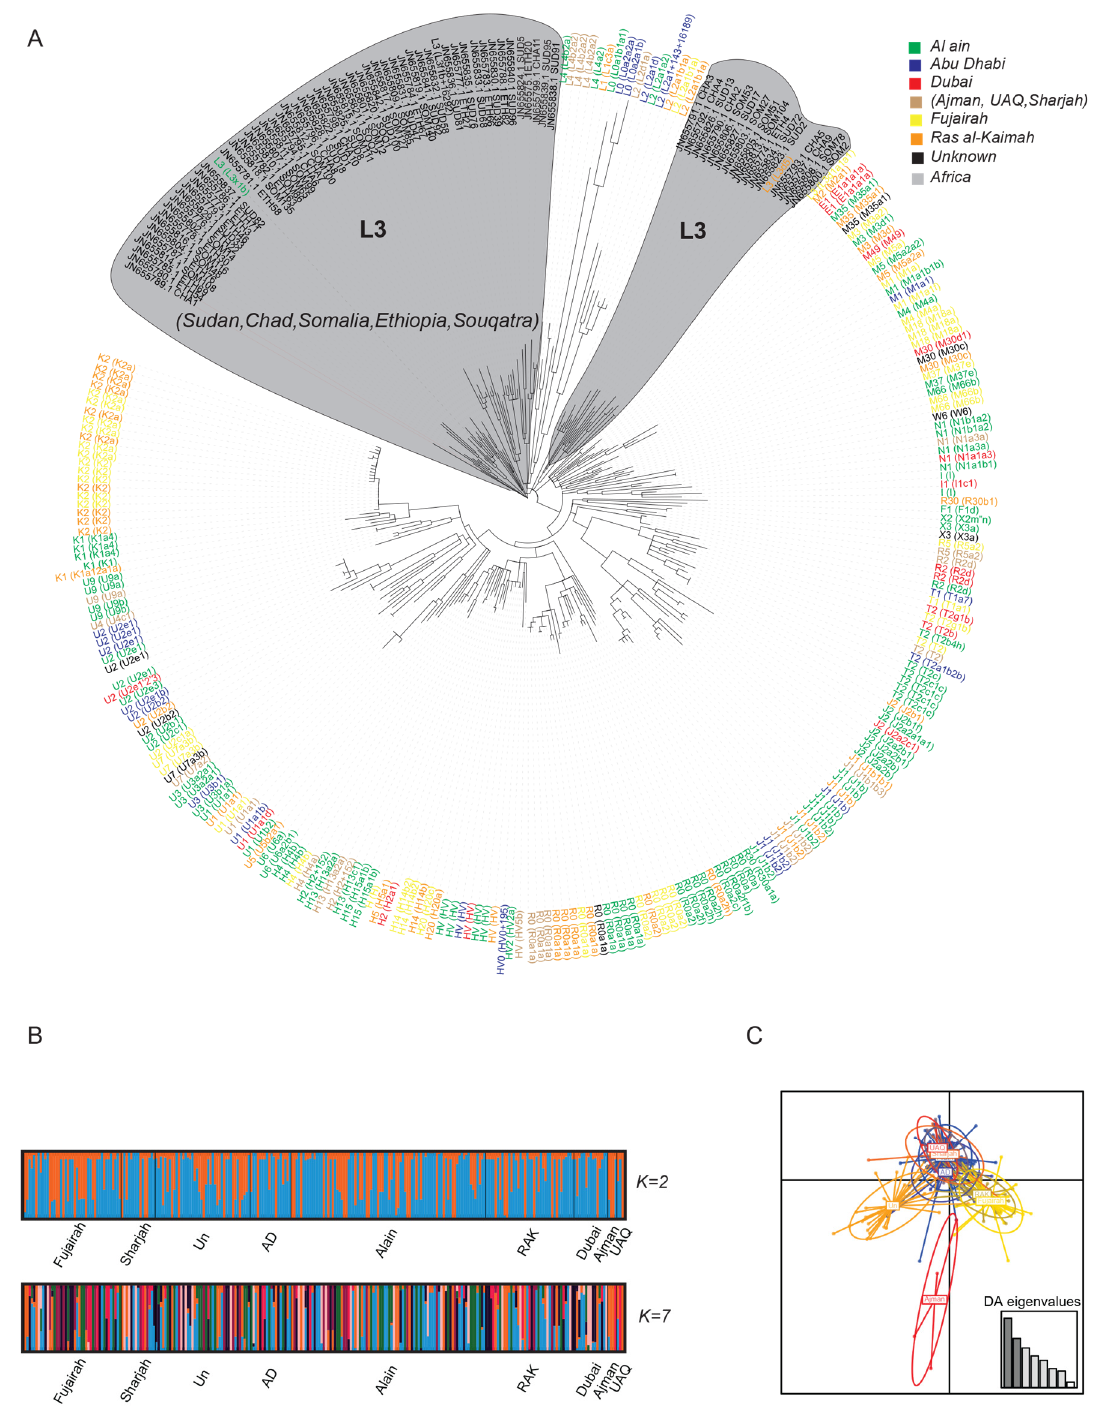
Figure 3. Population structure in UAE population. ( A ) Maximum likelihood phylogenetic tree depicting the network relationship among the di ff erent haplogroups (sub-haplogroups), where they are color-coded by city / region. ( B ) Admixture plot for K = 2 and K = 7 ancestral population. ( C ) Discriminant Analysis of Principal Component (DAPC) showing the clustering of the di ff erent cities of the UAE